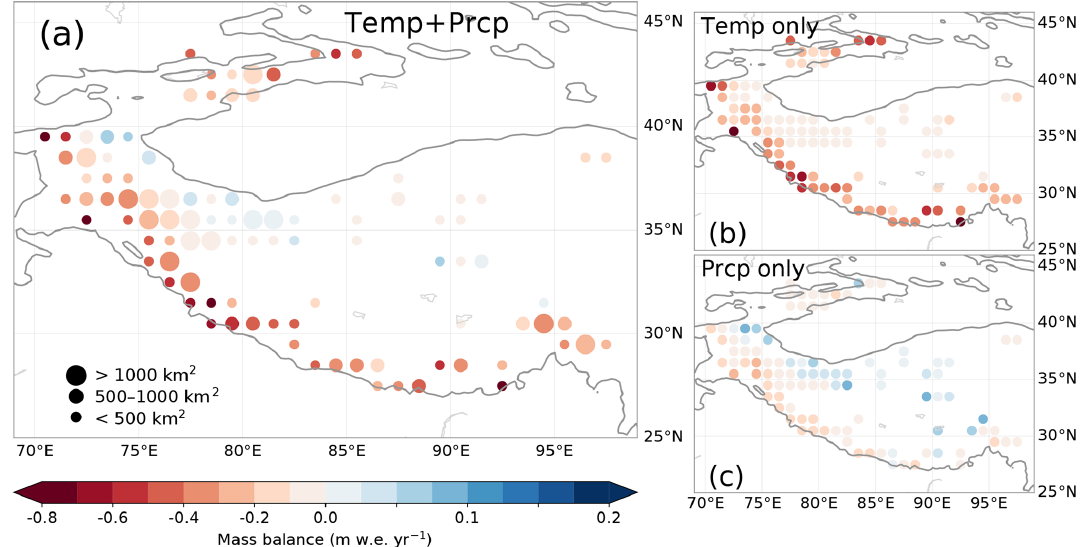
Figure 11. Simulated mean mass balance between 2000 and 2010 forced by changes in temperature and annual snowfall from WRF (a) , only changes in temperature from WRF (b) , and only changes in annual snowfall from WRF (c) . Results are binned in 1 ◦ × 1 ◦ bins, and bins with total glacier volumes less than 5km 3 are not shown to enable comparison with previous studies. The 2000m elevation contour is indicated by a solid line.